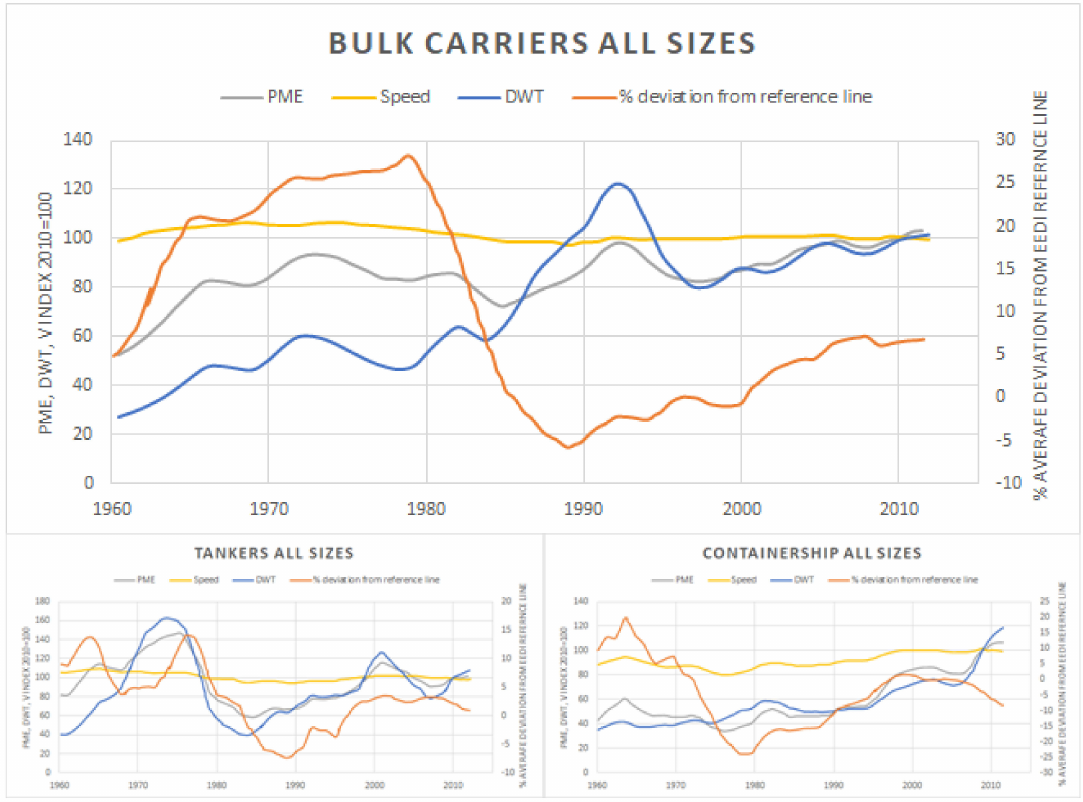
Figure 12. Development of design efficiency, main engine power, speed and capacity of new bulk carriers, 1960–2012, Design efficiency is defined as the EIV divided by EEDI reference line, averaged across all ships built in certain years. DOWN: Development of design efficiency, main engine power, speed and capacity of new tankers and container ships up to 2012, adapted from